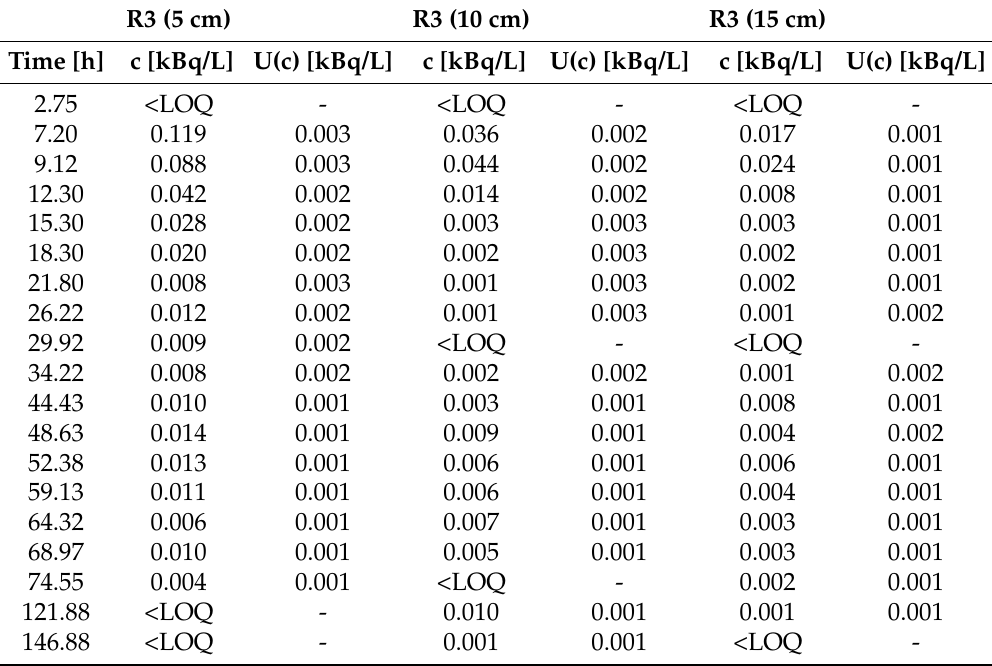
Table A7. Hyporheic 32 P activity concentrations and their analytical uncertainties at point R3.